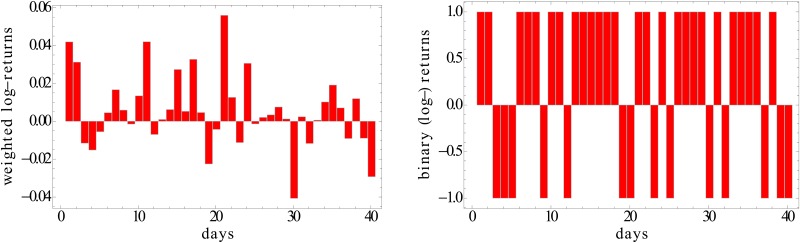
‘Weighted’ (left) versus ‘Binary’ (right) time series of log-returns of the Apple stock over a period of 40 days starting from 7/5/2011.